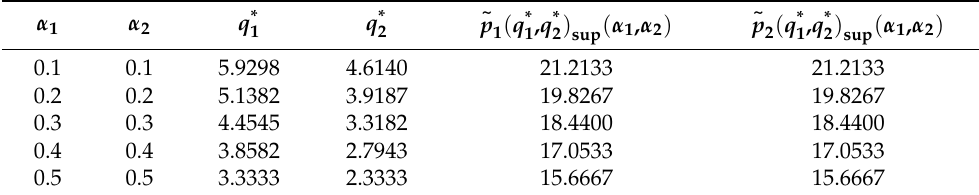
Table 4. ( α 1 , α 2 )-optimistic equilibrium quantity for Scenario I when the risk aversion levels for CDT and AG increase.